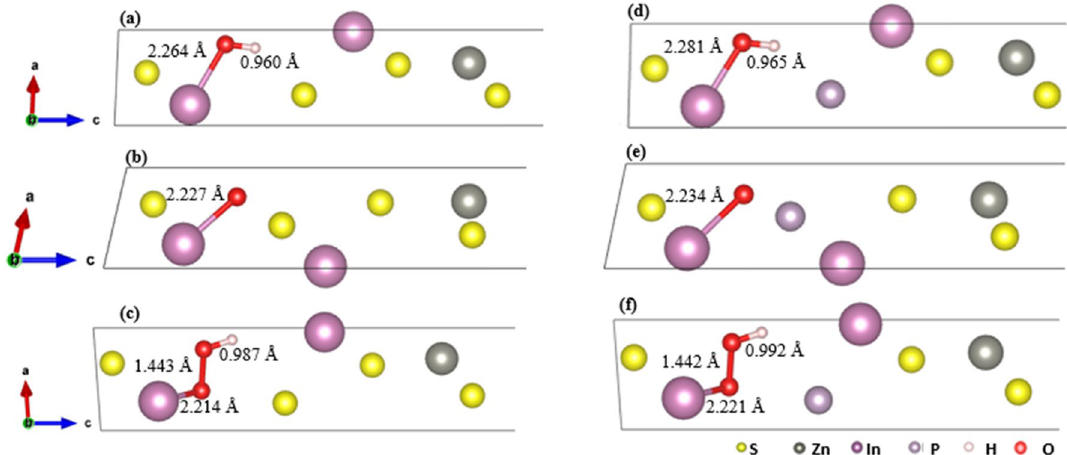
Figure 8. Intermediate reaction steps for monolayer ZIS forming ( a ) HO*, ( b ) O* and ( c ) HOO*, as well as for monolayer P-ZIS forming ( d ) HO*, ( e ) O* and ( f )